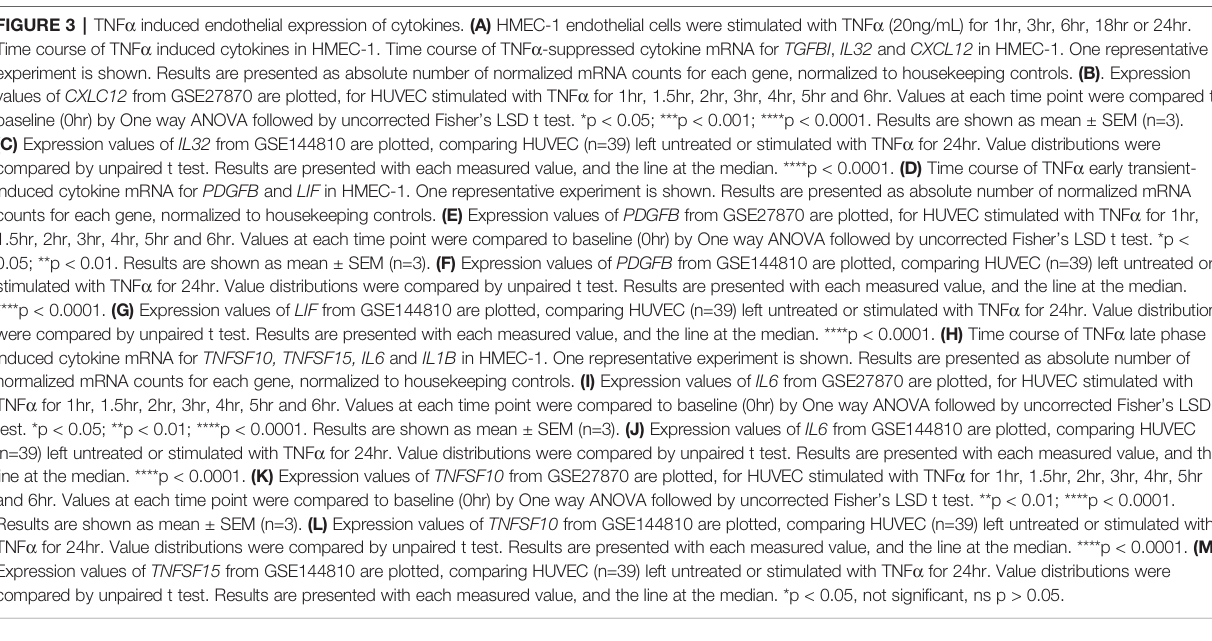
Figure S7 ). Enhanced HLA class I protein expression on primary endothelial cells was seen as early as 18hr, and continued to increase through 48hr of continuous IFN g exposure (aortic EC: Figure 7H; 6 primary vascular beds: Figure 7I ). HLA-DR protein expression was comparatively delayed, with low and inconsistent upregulation at 18-24hr and highest cell surface expression at 48hr (aortic EC: Figure 7H; 6 primary vascular beds: Figure 7I